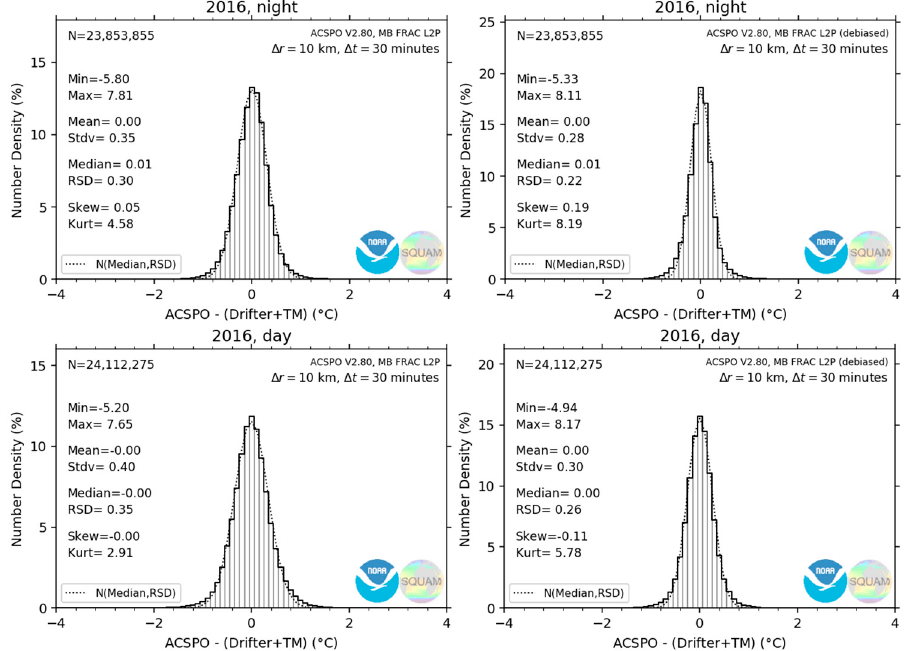
Figure 8. Yearly aggregated histograms of ACSPO—(D + TM) SST for Metop-B in 2016. ( Left ) night; ( right ) day; ( top ) GR; ( bottom ) PWR.